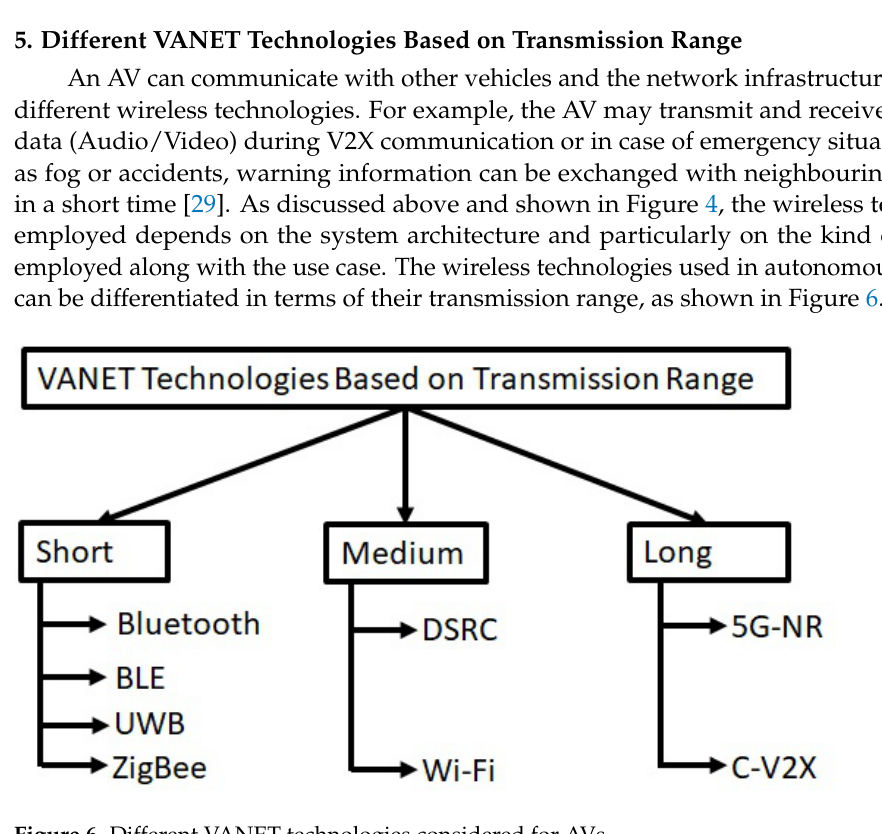
Figure 6. Different VANET technologies considered for